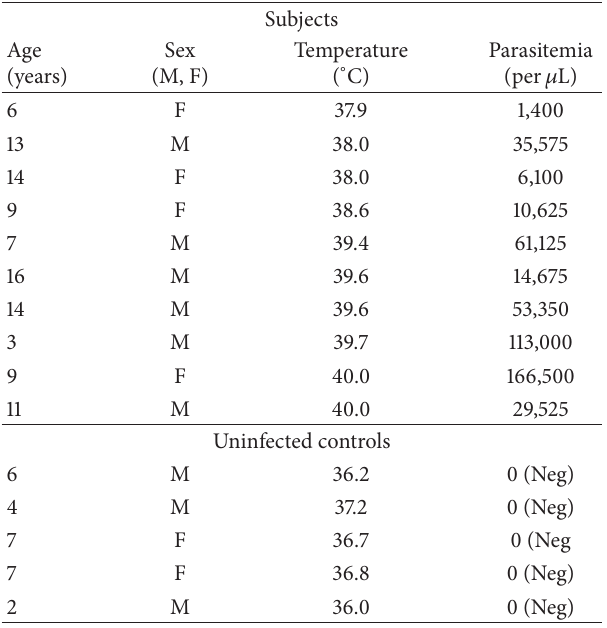
Table 1: Baseline information at the time of enrollment: subjects with uncomplicated P. falciparum malaria and uninfected